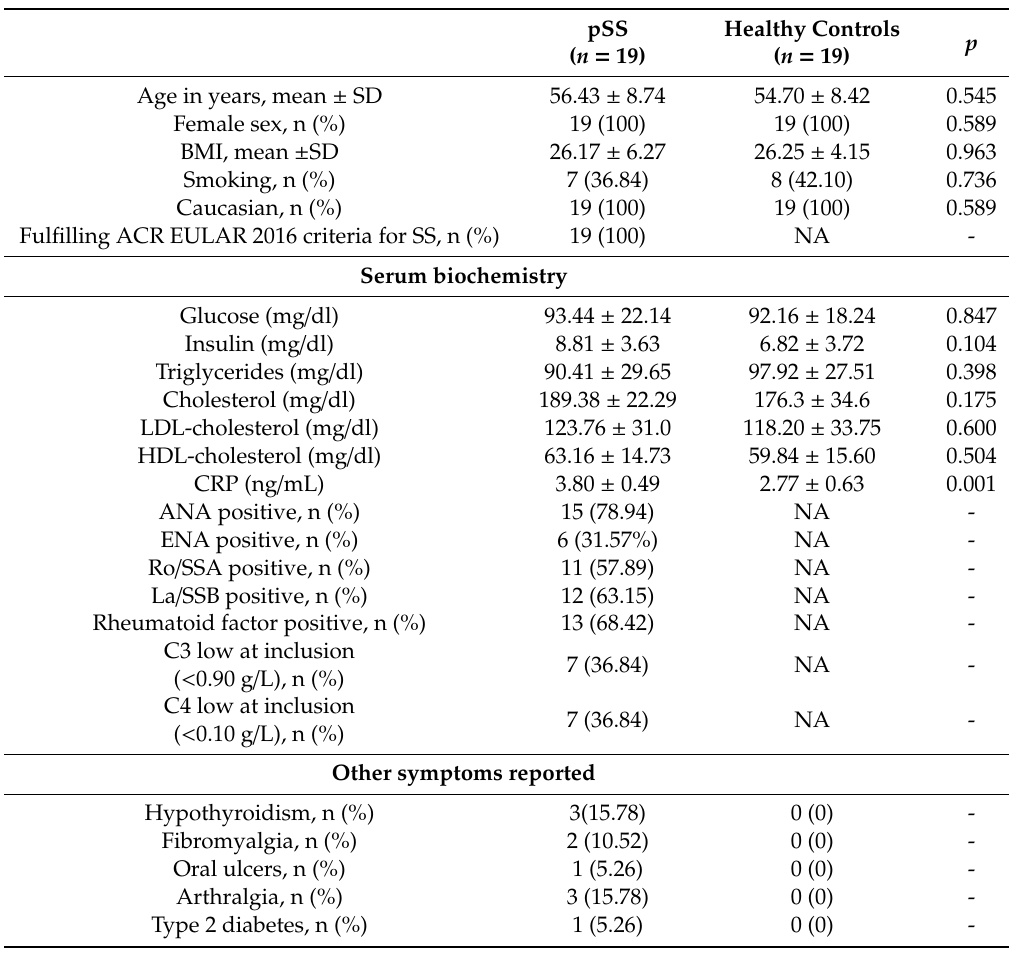
Table 1. Demographic and clinical characteristics of primary Sjögren’s syndrome (pSS) patients and healthy